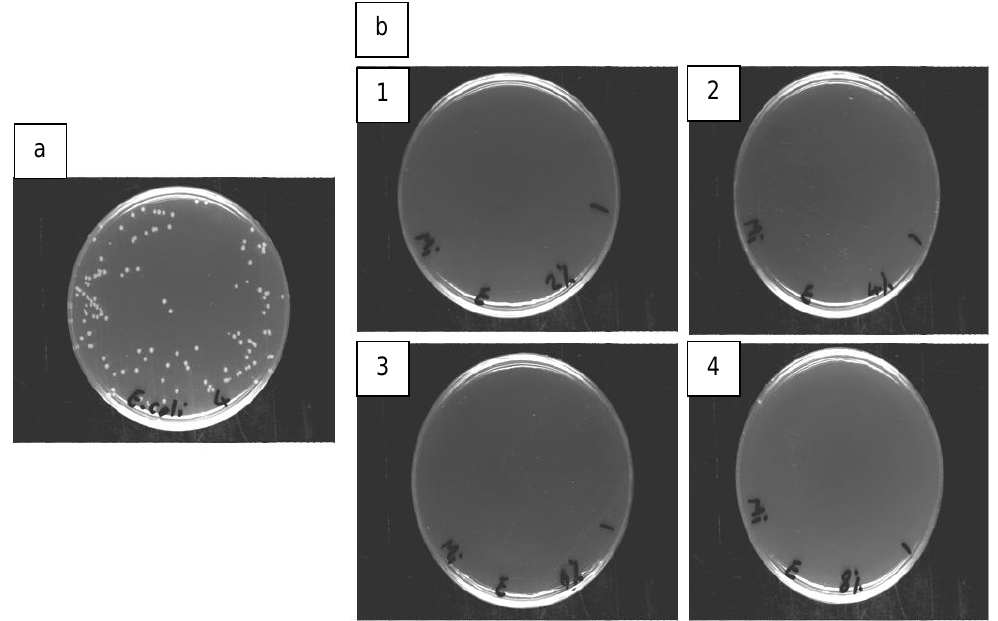
Fig. 7. Antibacterial activity of AgNP@EPR composites against E. coli (a) blank without composite (b) in present of composites (1) 2 vol% (2) 4 vol% (3) 6 vol% (4) 8 vol% AgNP.